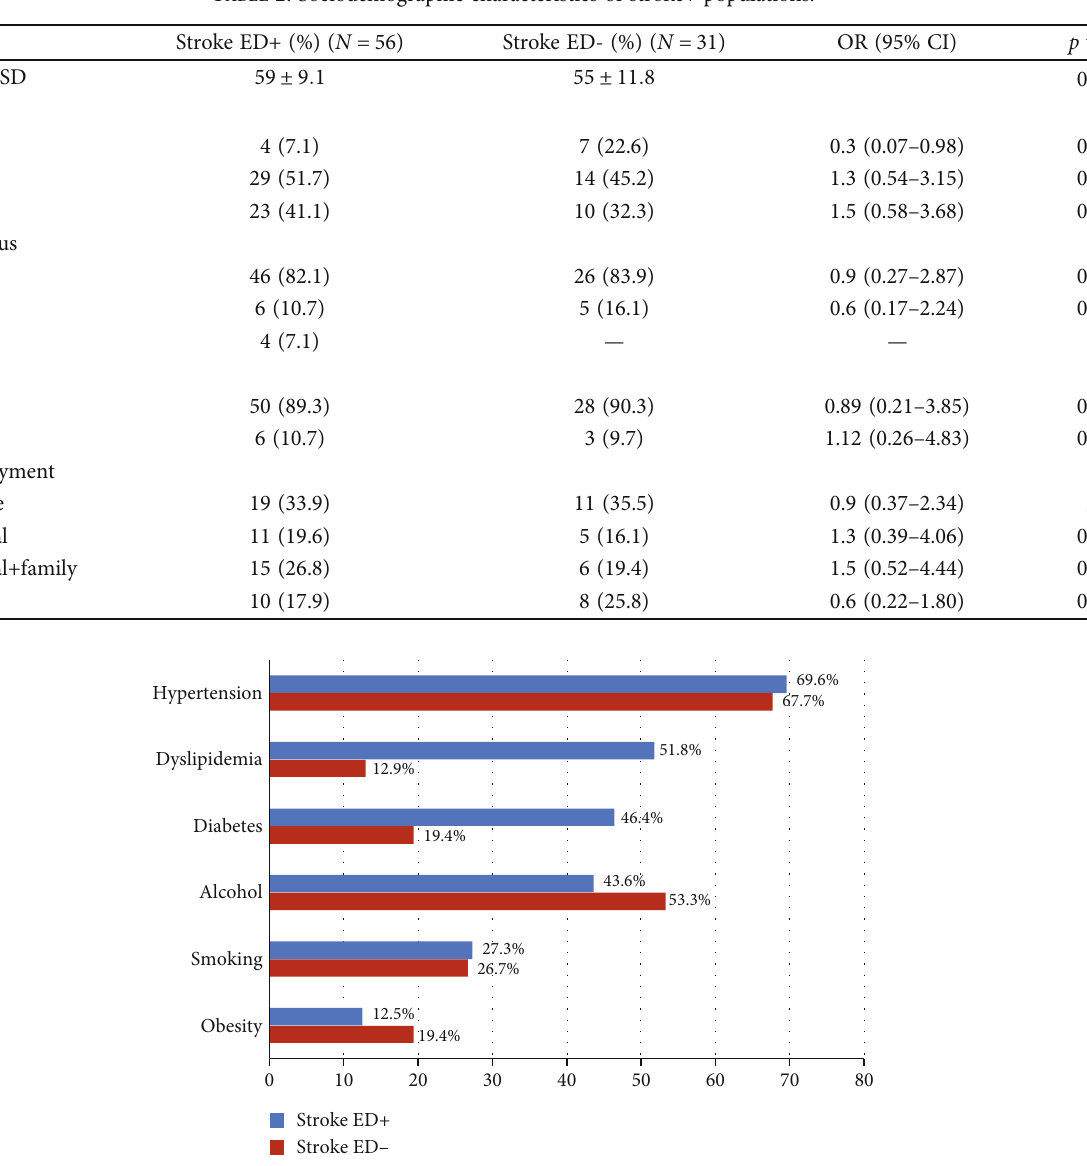
Figure 1: Cerebrovascular risk factors among stroke+ patients with and without